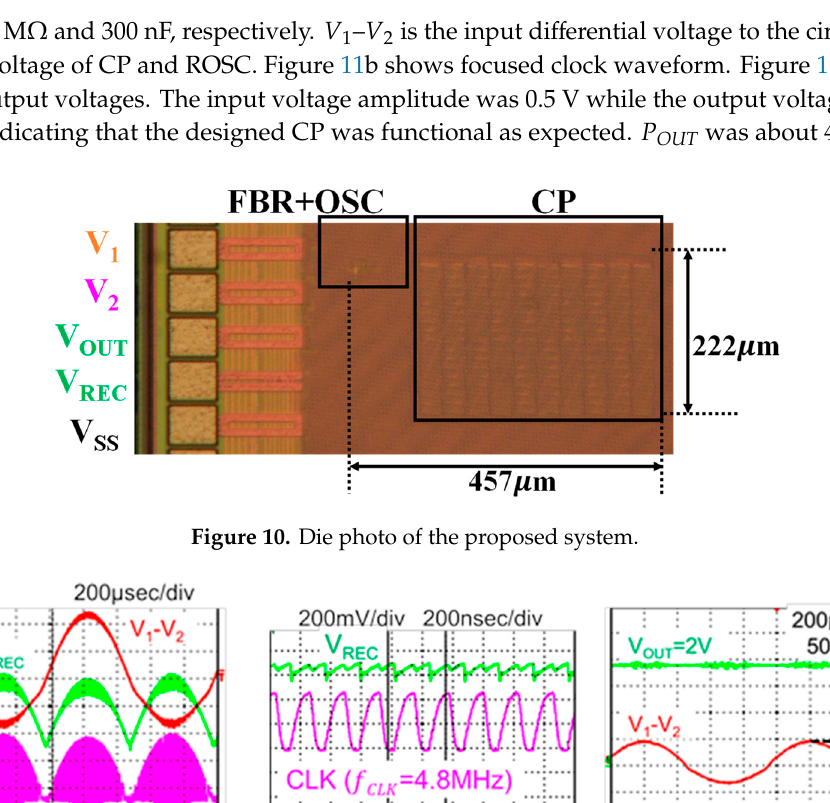
Figure 11. Measured waveforms ( a ) V 1 – V 2 , V REC and CLK, ( b ) CLK and V REC , ( c ) V 1 − V 2 and V OUT .